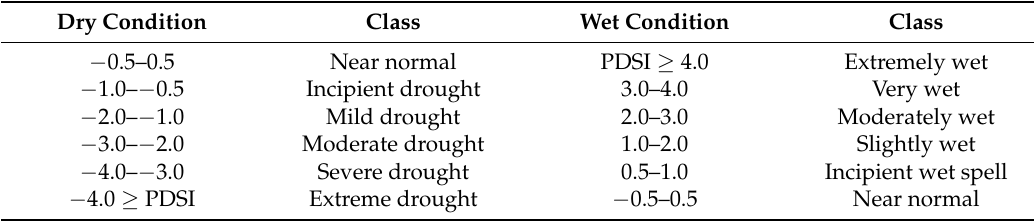
Table 6. Range of PDSI according to dry and wet